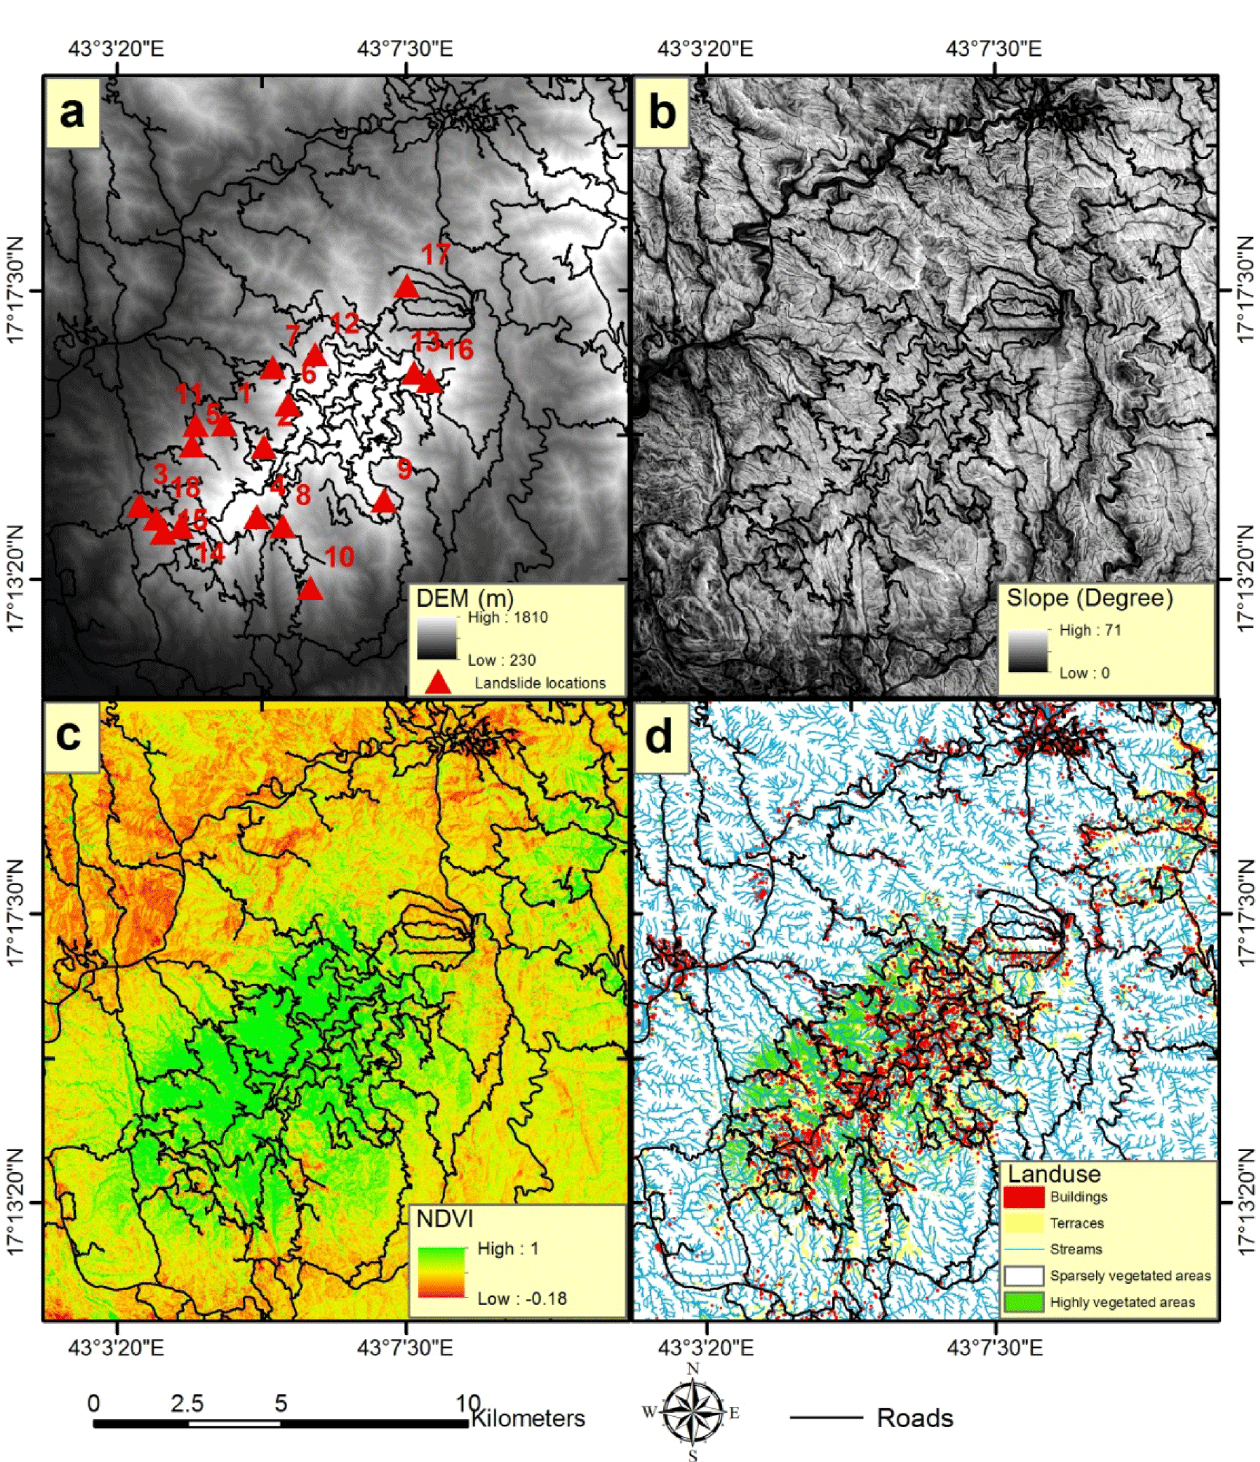
Figure 2. (a) Location map showing the distribution of landslides that were visited in the field (1–3, 6, 8, 10, 13–18) and a selected suite of similar landslides that were extracted from remotely acquired data (4, 5, 7, 9, 11, 12); background DEM image. (b) Map showing the distribution of slopes in the study area. (c) Color-coded NDVI image generated from SPOT image. (d) Land use map for the study area showing the distribution of roads, buildings, and terraces extracted manually from Google Earth images; stream networks extracted from 10m DEM; and highly vegetated areas (NDVI: 0.09 to 1) and sparsely vegetated areas (NDVI: − 0.18 to 0.09) generated from SPOT imagery. Also shown are the distributions of road